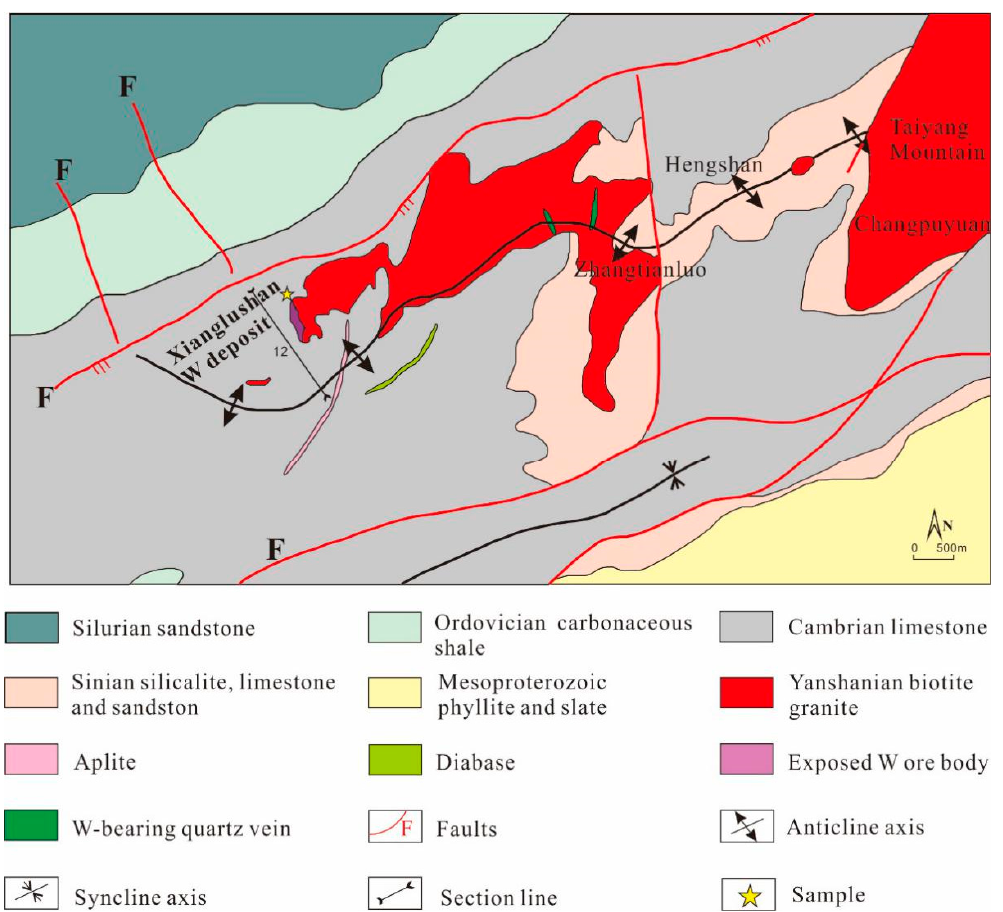
Figure 2. Simplified geologic map of the Xianglushan deposit (modified from [24,25]).